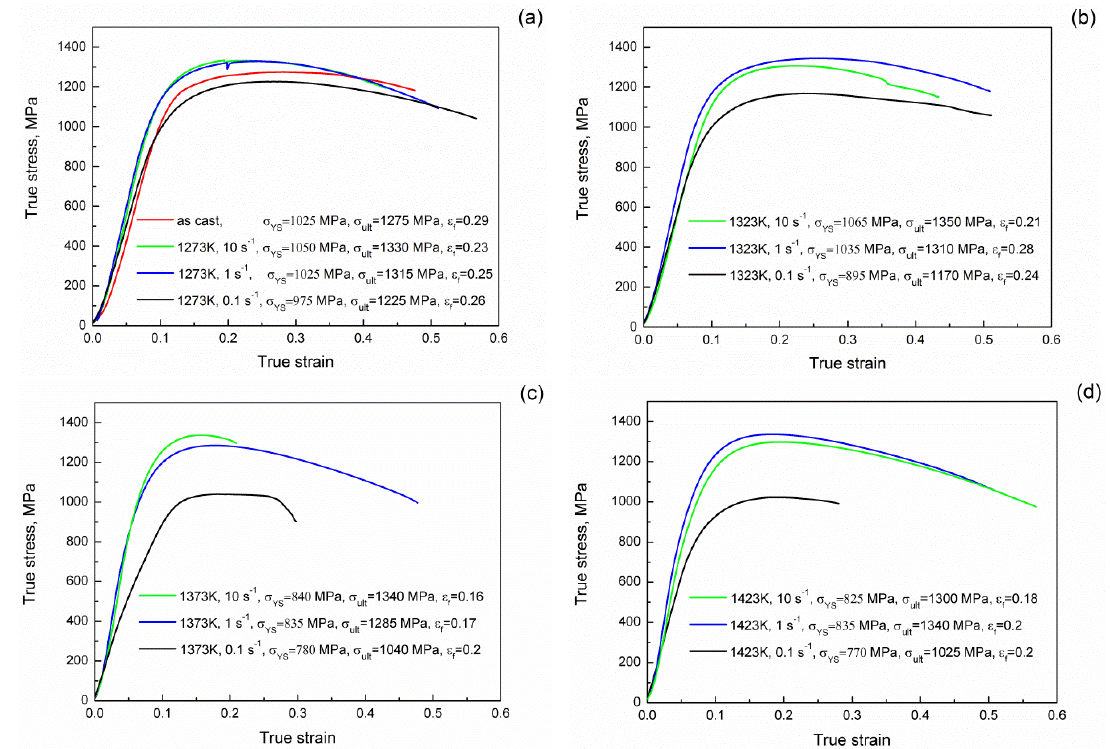
Figure 7. Mechanical properties of the investigated steel after hot deformation.